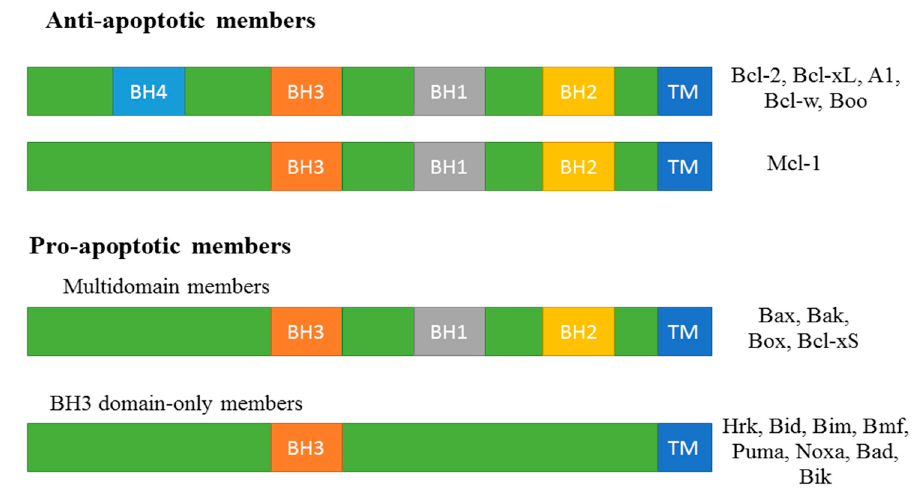
Figure 2. Bcl-2 Proteins. The Bcl-2 proteins can be subdivided into pro-survival and pro-apoptotic members, and have single or mutiple conserved functional Bcl-2 homology